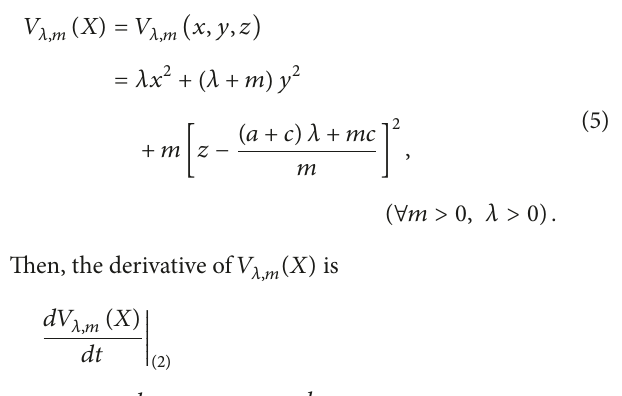
where 𝑟, 𝜎, 𝑏 > 0 and parameter 𝑎 is real. System (1) is when 𝑎 = 0 coincides with the classical Lorenz system